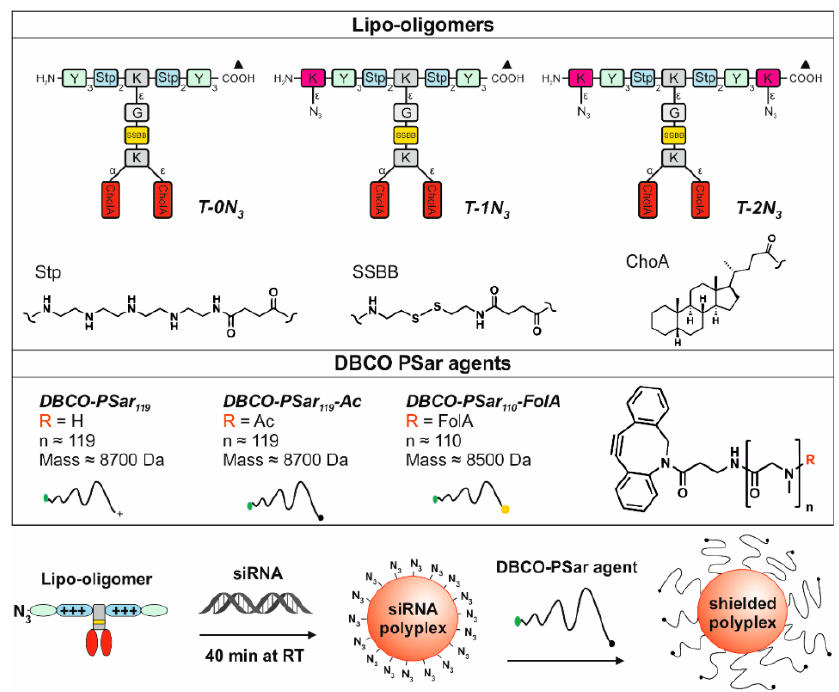
Figure 1. Overview of chemical compounds. Table, top : structural illustration of sequence-defined oligomers with T-shape topology; T-0N 3 (ID: 992 published [39]), T-1N 3 (ID: 1073 ) and T-2N 3 (ID: 1086 ) with no, one or two terminal azidolysines K(N3). Further units of the oligomers: Stp: succinoyl-tetraethylene-pentamine, ssbb: succinoyl-cystamine, CholA: 5 β -Cholanic acid, Y: tyrosine, K: lysine, G: glycine. The broken lines represent amide linkages, the triangle ( ▲ ) is the starting point of the synthesis. IDs are unique database identification numbers. Table, bottom : chemical structure of the shielding agents DBCO-pSar 119 , DBCO-pSar 119 -Ac and DBCO-pSar 110 -FolA . Scheme of the formulation of a shielded polyplex.